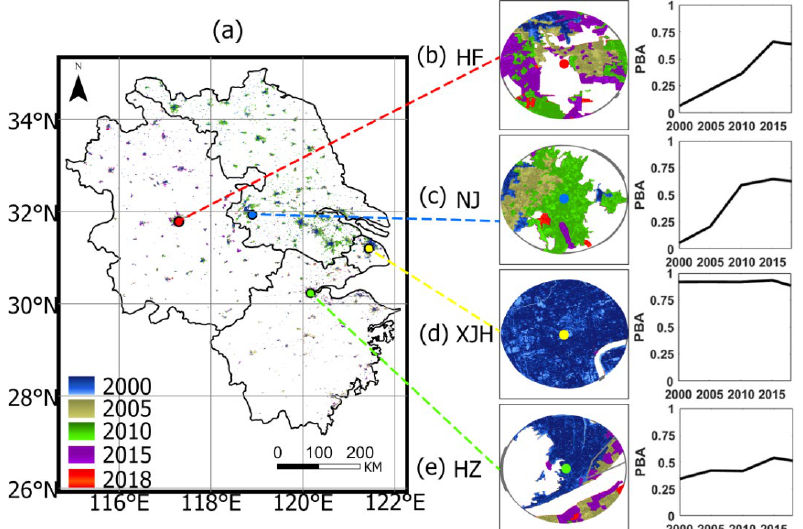
Figure 2. ( a ) Maps of the change in the extent of built-up areas in the YRD from 2000 to 2018. Annual change and line graphs of the PBA in the buffer zone within a 5-km radius centered on the meteorological stations of the four provincial capital cities of ( b ) Hefei (HF), ( c ) Nanjing (NJ), ( d ) Xujiahui (XJH) and ( e ) Hangzhou (HZ).